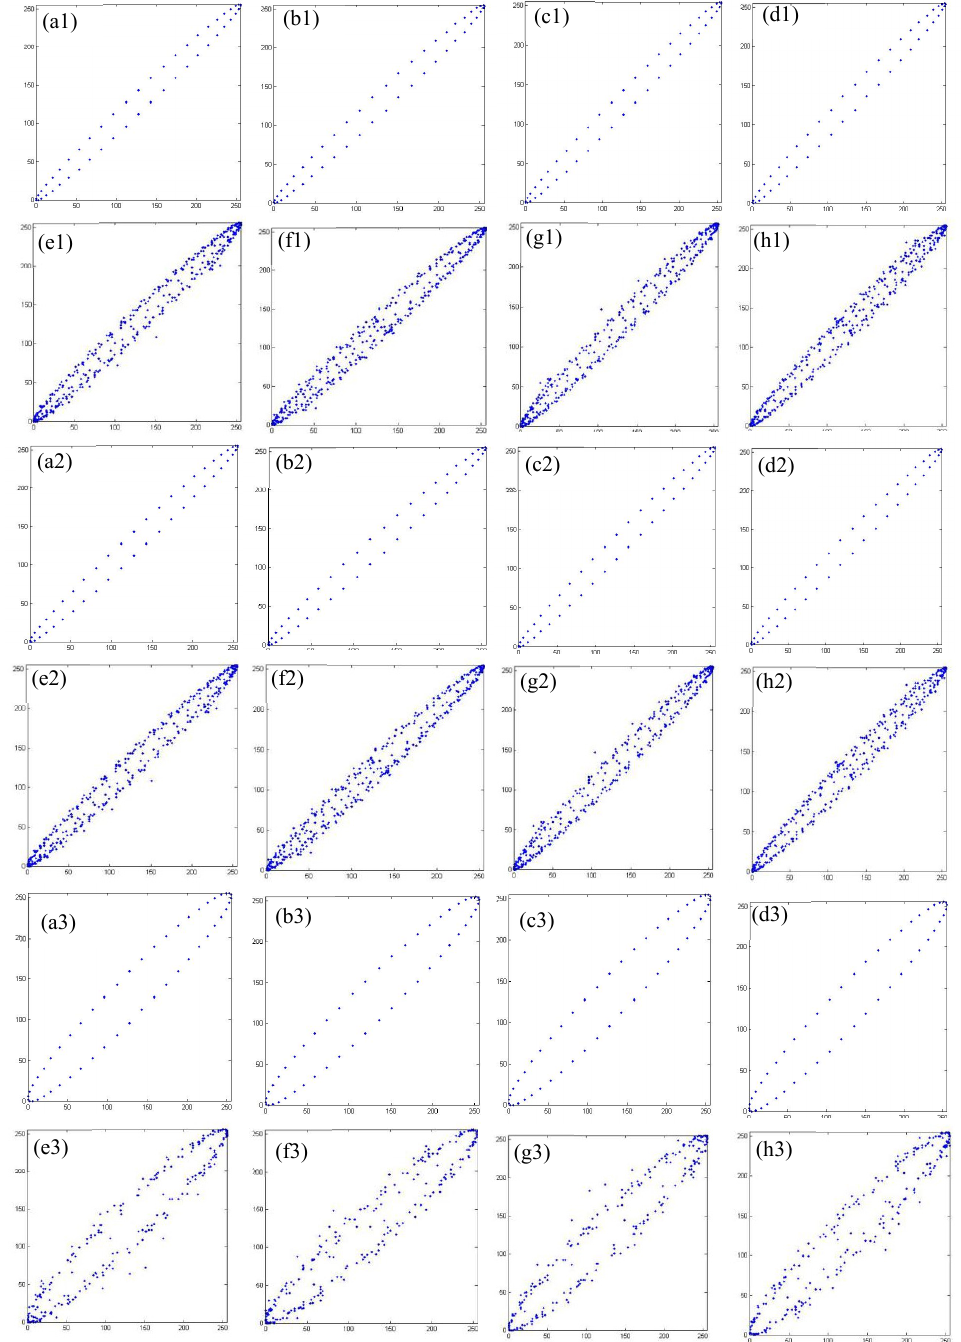
Figure 11. The correlation of adjacent pixels of thee eight original images. ( a1 – h1 ) The correlation of adjacent pixels of the eight original images in the horizontal direction, ( a2 – h2 ) in the vertical direction, and ( a3 – h3 ) in the diagonal direction.